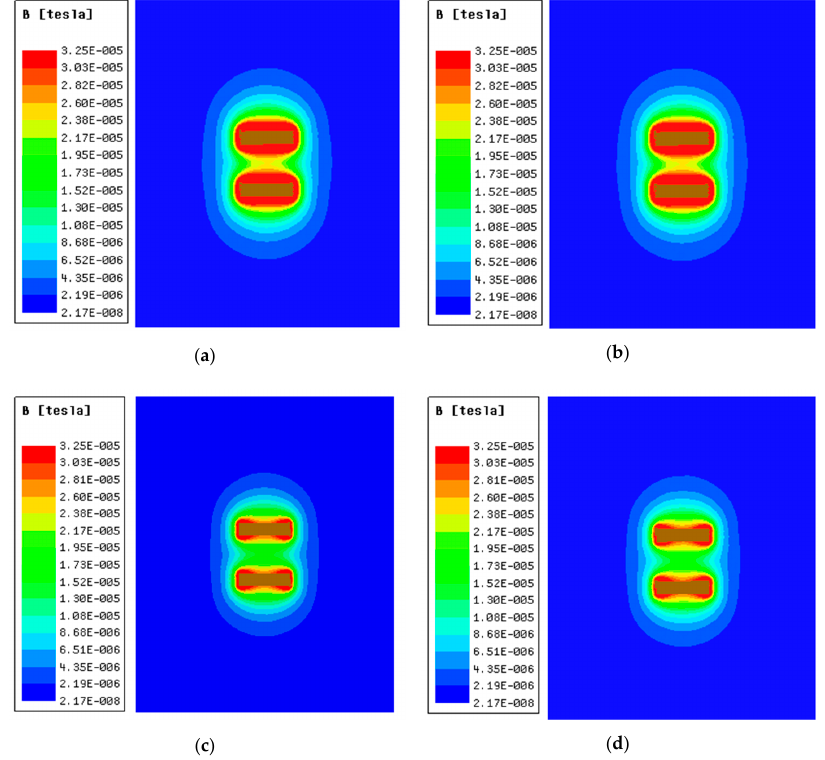
Figure 10. ( a ) Simulation result of B-field strength in case 1; ( b ) simulation result of B-field strength in case 2; ( c ) simulation result of B-field strength in case 3. ( d ) simulation result of B-field strength in case 4.